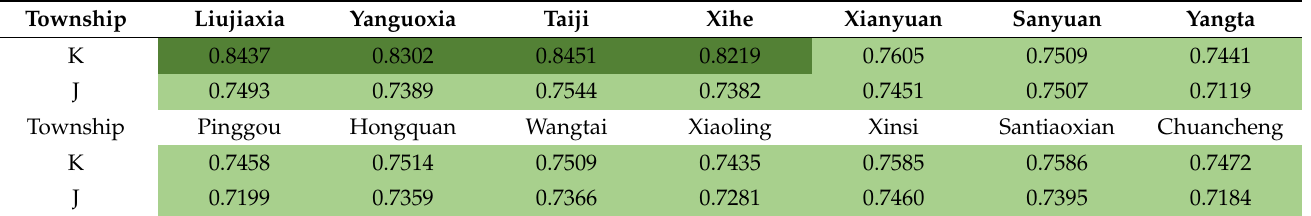
Table 7. Comprehensive evaluation results and coordinated development types of ecological migra- tion areas in Liujiaxia Reservoir Area.